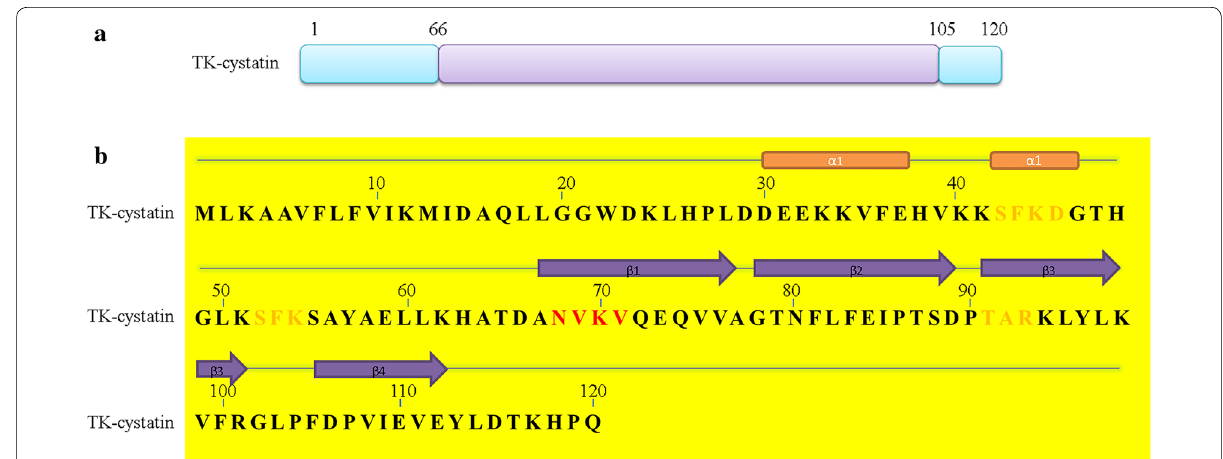
Fig. 2 Molecular characteristics of the amino acid sequence of TK-cystatin. a Domain of TK-cystatin, schematic view of the position of domains in the amino acid sequence (Lavender indicated the position of the cystatin domain in the sequence). b The secondary structure was marked in the amino acid sequence (Red and orange represented N -glycosylation and phosphorylation sites; orange rectangular for α-helices, deep purple arrow for β-strand)